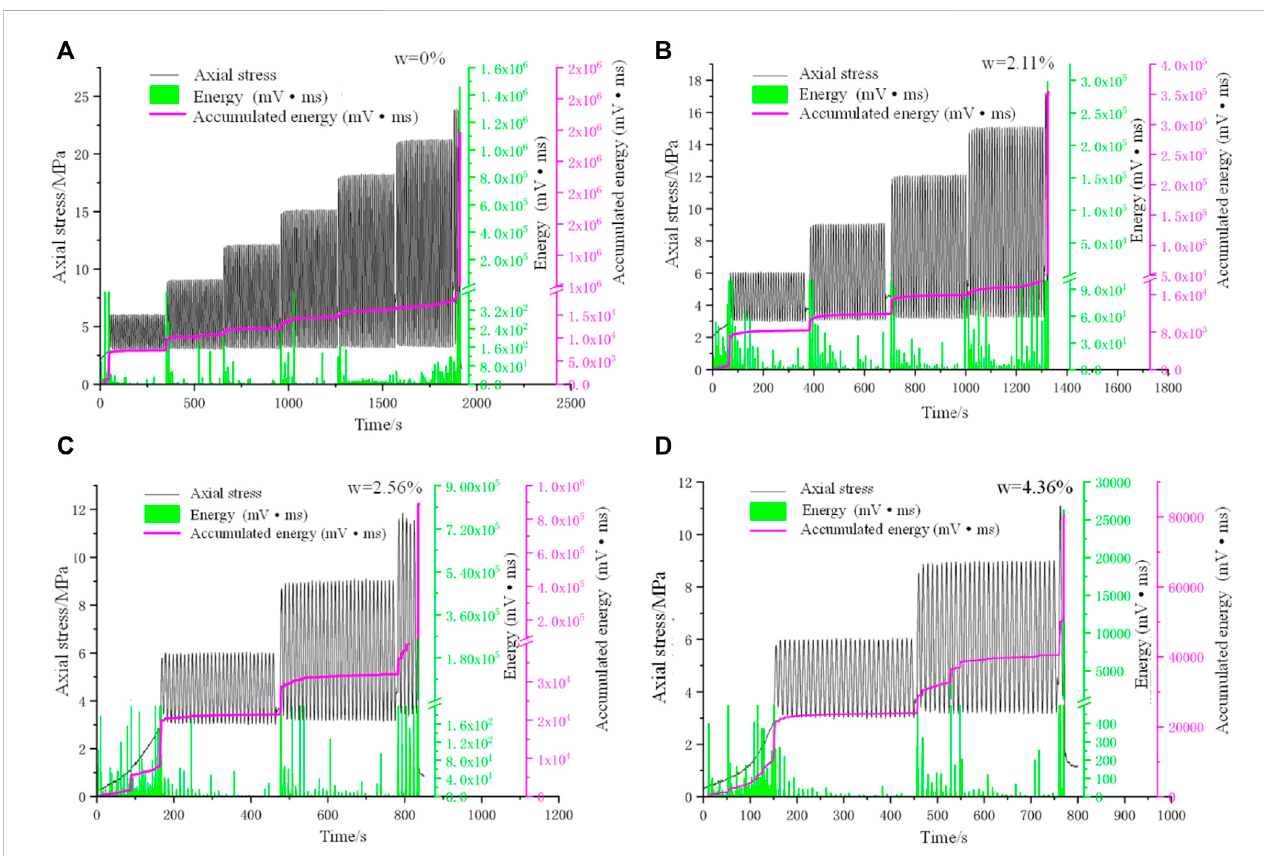
FIGURE 11 Plots of the AE energy and accumulative energy distribution against experimental time. (A-D) The tested rock samples with water content of 0%, 2.21%, 2.56%, and 4.36%,